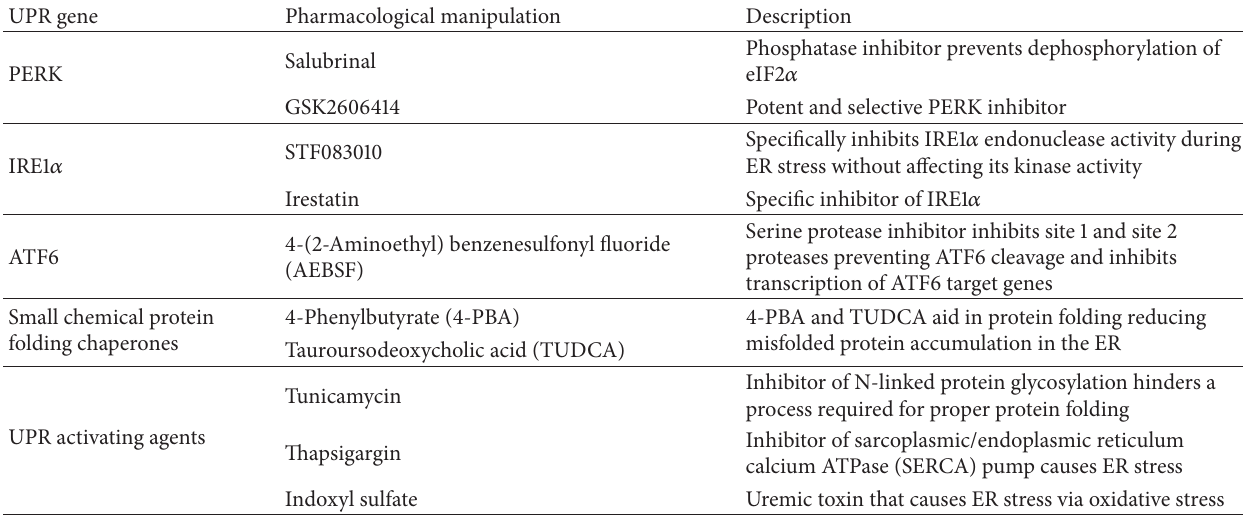
Table 1: Pharmacological manipulation of the UPR. To study the various pathways of the UPR, pharmacological manipulations to the specific pathways can be utilized. To examine the PERK pathway, salubrinal is an inhibitor of the dephosphorylation of eIF2 𝛼 . To investigate the IRE1 pathway, STF-083010 and Irestatin are inhibitors of IRE1 endonuclease activity. The ATF6 pathway can be inhibited with 4-(2-aminoetheryl) benzenesulfonyl fluoride (AEBSF) to prevent cleavage of ATF6. The role of protein folding chaperones can be determined by utilizing artificial chaperones including 4-phenylbutyrate (4-PBA) and tauroursodeoxycholic acid (TUDCA), which aid in the folding of proteins. Further, to investigate sustained activation of the unfolded protein response, classic ER stress inducers, tunicamycin and thapsigargin, can be used as well as disease-related inducers including indoxyl